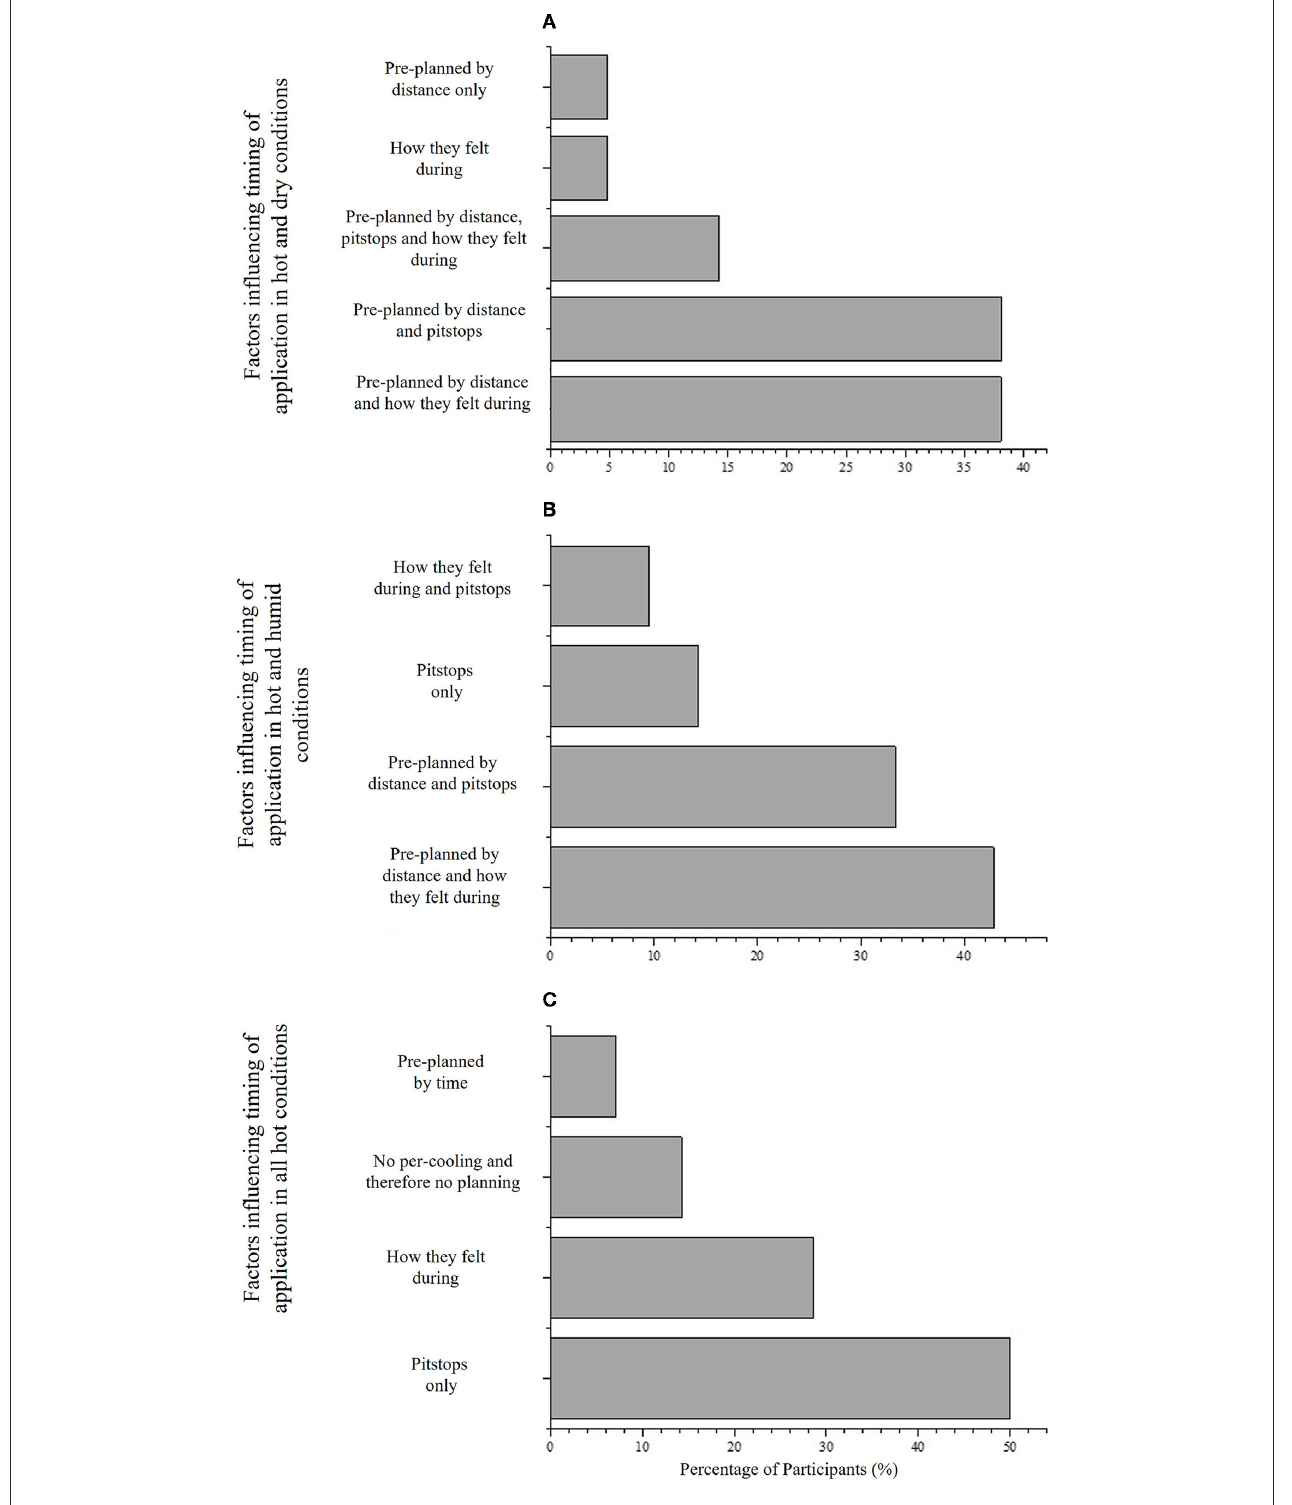
FIGURE 4 | (A) Timing of cooling strategies employed in hot and dry conditions by 60% ( N = 21) participants who use different strategies depending on condition, (B) timing of cooling strategies employed in hot and humid conditions by 60% ( N = 21) participants who use different strategies depending on condition, and (C) timing of strategies employed in all hot conditions by 40% ( N = 14) participants who employed the same strategy regardless of condition.